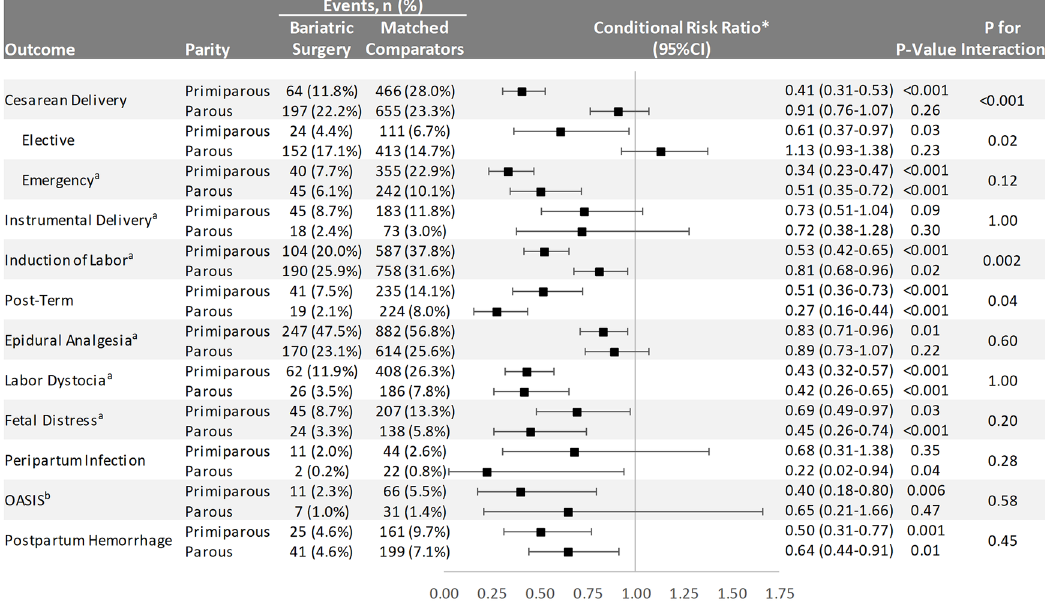
Fig 4. Delivery outcomes in singleton live term births in Sweden between 2006 and 2013 stratified by parity. OASIS = obstetric anal sphincter injury (perineal tear grade III–IV). Emergency cesarean delivery = all unplanned cesarean sections. a Elective cesarean deliveries excluded. b Cesarean deliveries excluded. (cid:3) Conditioned on the matching factors maternal age, parity, pre-surgery BMI category (using early-pregnancy BMI in controls), early-pregnancy smoking status, educational level, height, country of birth, and delivery